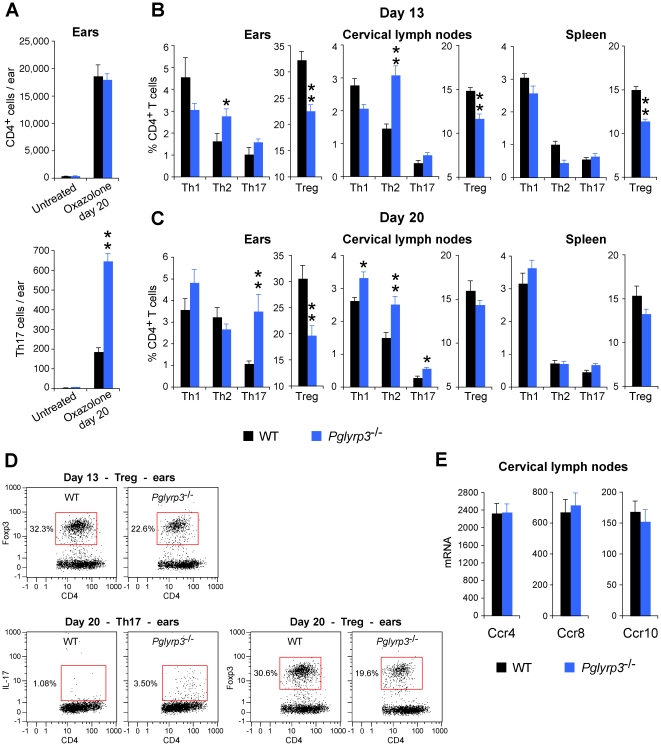

Pglyrp3
−/− mice have high numbers Th17 and low numbers of Treg cells in the affected skin in the oxazolone model of atopic dermatitis.(A) Numbers of CD4+ cells and Th17 cells in the ears or (B–D) percentages of Th1, Th2, Th17, and Treg cells in the ears, cervical lymph nodes, and spleen in sensitized WT and Pglyrp3
−/− mice on days 13 or 20 of ear treatment with oxazolone, measured by flow cytometry; means ± SEM of 5–9 mice/group (*, P<0.05; **, P<0.005; Pglyrp3
−/− versus WT) or representative dot plots are shown. (E) Expression of receptors for chemokines that attract Treg cells in cervical lymph nodes of sensitized WT and Pglyrp3
−/− mice on day 20 of ear treatment with oxazolone measured by qRT-PCR; amounts of mRNA are shown as means ± SEM of 3 arrays from 5 mice/group.